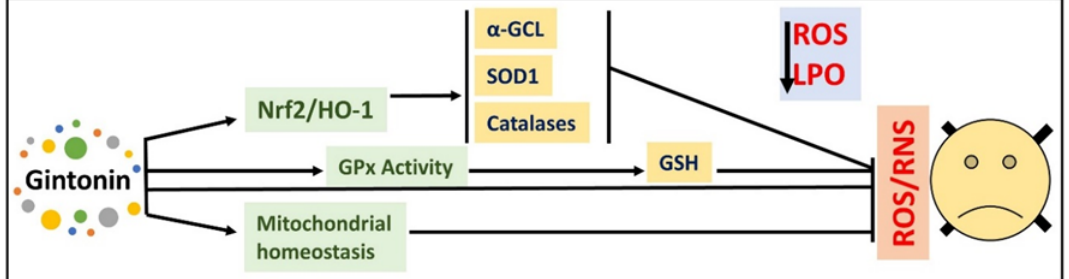
Figure 8. Graphical illustration showing the antioxidant potential of gintonin against elevated oxidative stress and neurodegeneration. Nrf2: nuclear factor erythroid 2-related factor 2, HO-1: Heme oxygenase-1, GCL: Glutamate Cysteine Ligase, SOD1: Superoxide Dismutase 1, RSO: Reactive Oxygen Species, LPO: Lipid peroxidation, RNS: Reactive nitrosative species, GSH: Glutathione, GPx: Glutathione peroxidase.